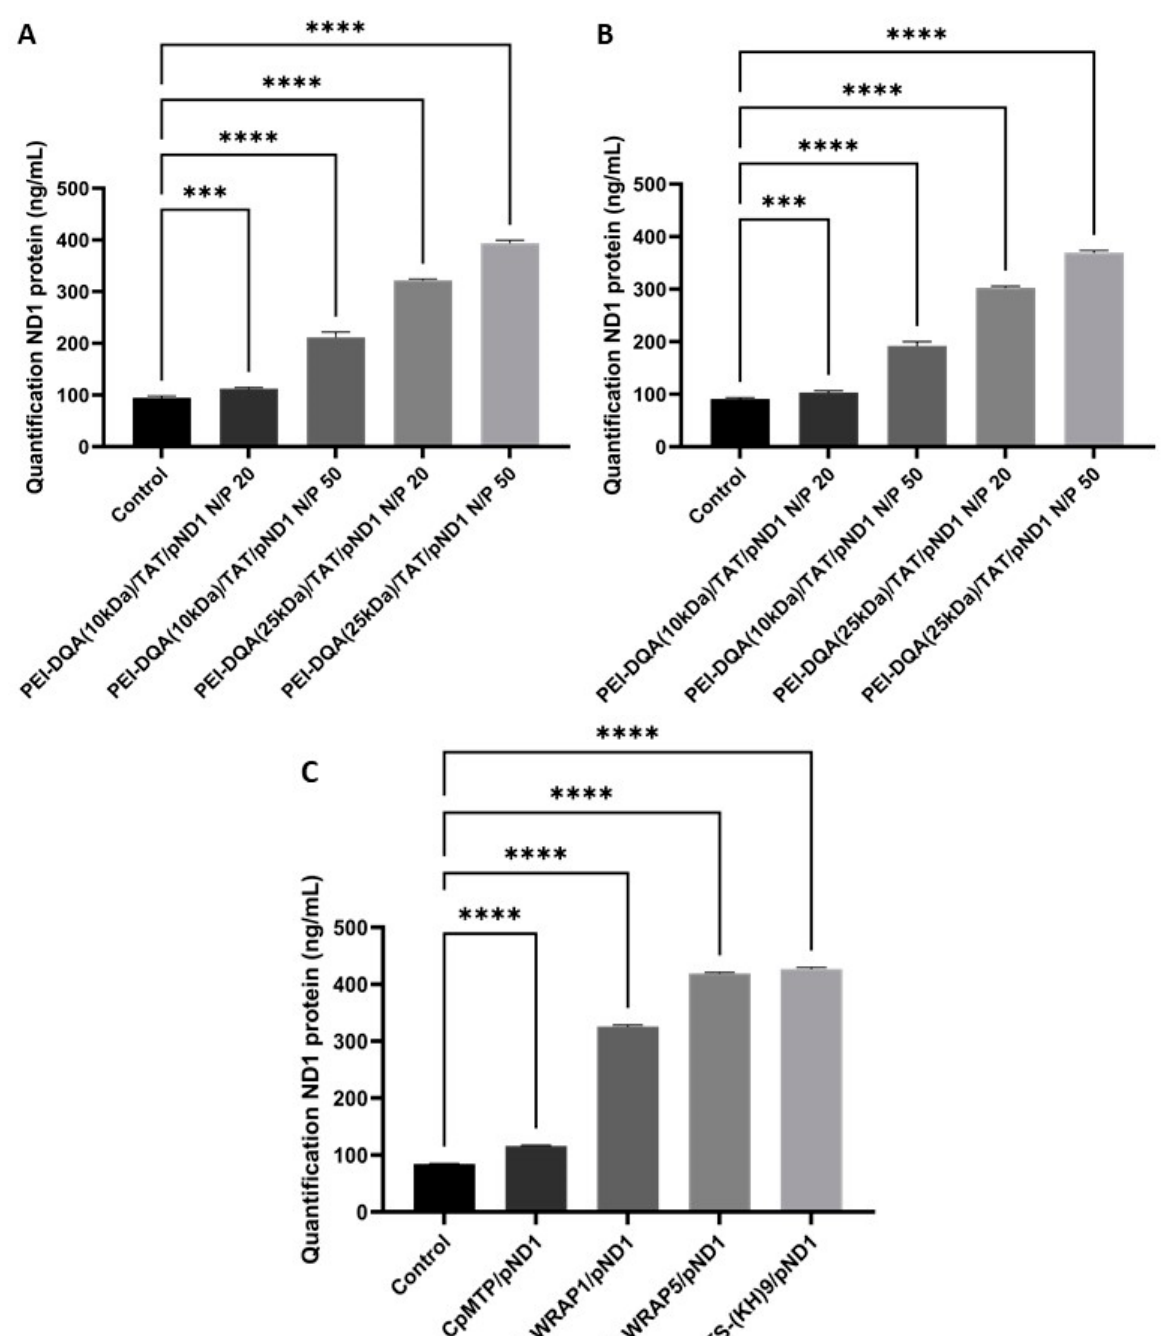
Figure 13. Quantification of ND1 protein 48 h after transfection of fibroblasts ( A ) and HeLa cells ( B ) with PEI–DQA (10 kDa)/TAT/pND1, N/P = 20:2:1; PEI–DQA (10 kDa)/TAT/pND1, N/P = 50:2:1;